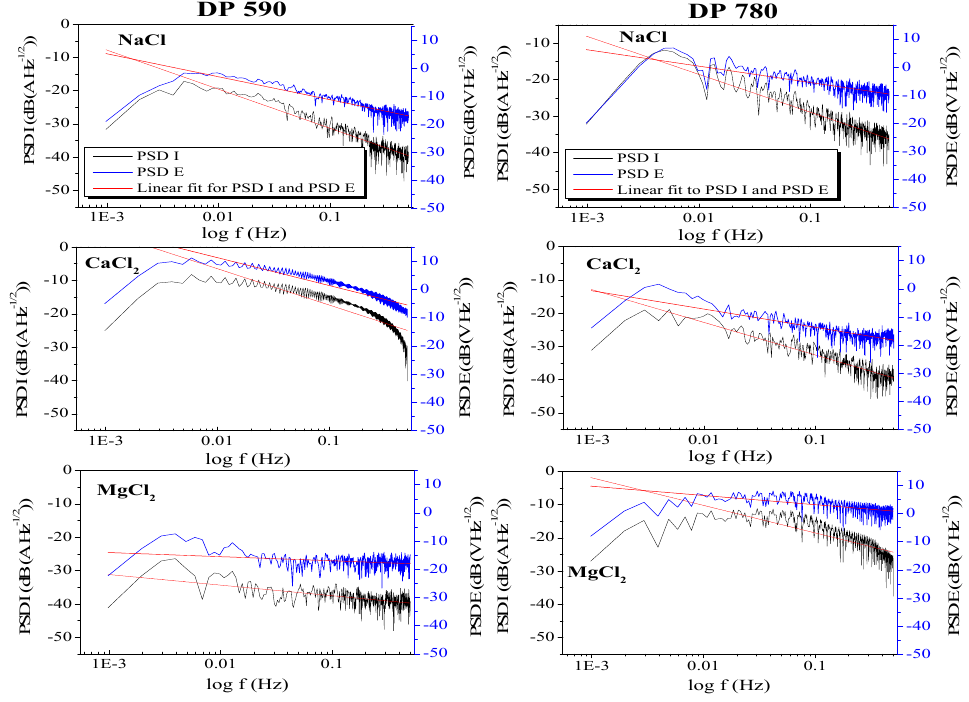
Figure 7. EN data in frequency domains for DP steels exposed in NaCl, CaCl 2 and MgCl 2 solutions.